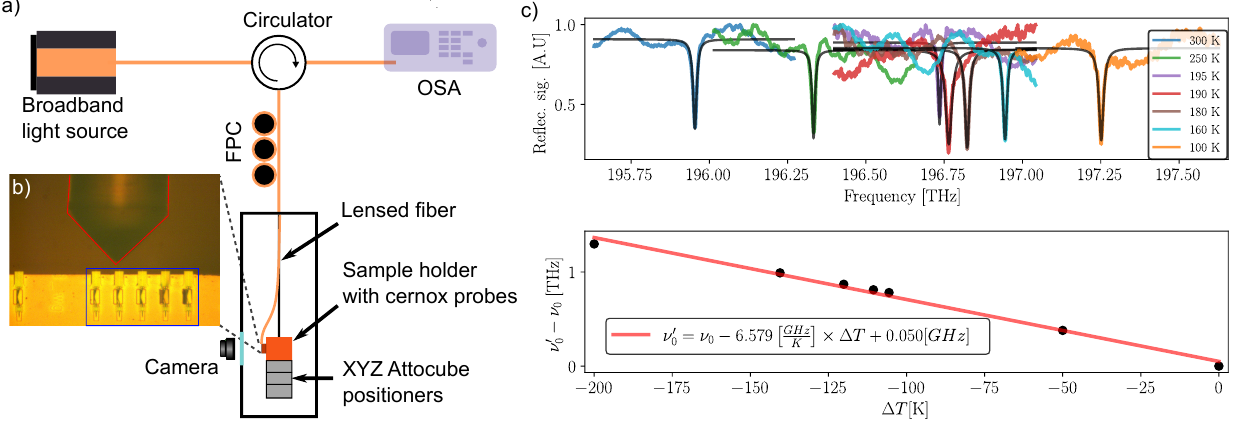
Figure 8. Optical setup and photonic results. ( a ) Schematic of the photonic characterization setup. A broadband light source (SLED) is used to align the sample with respect to the fiber using XYZ attocube micropositioners. The reflected signal is monitored with an optical spectrum analyzer (OSA). FPC: Fibered polarization controller; ( b ) image from the alignment camera, the fiber is outlined in red and the samples in blue; ( c ) optical resonance frequency shift due to thermorefractive and thermal expansion